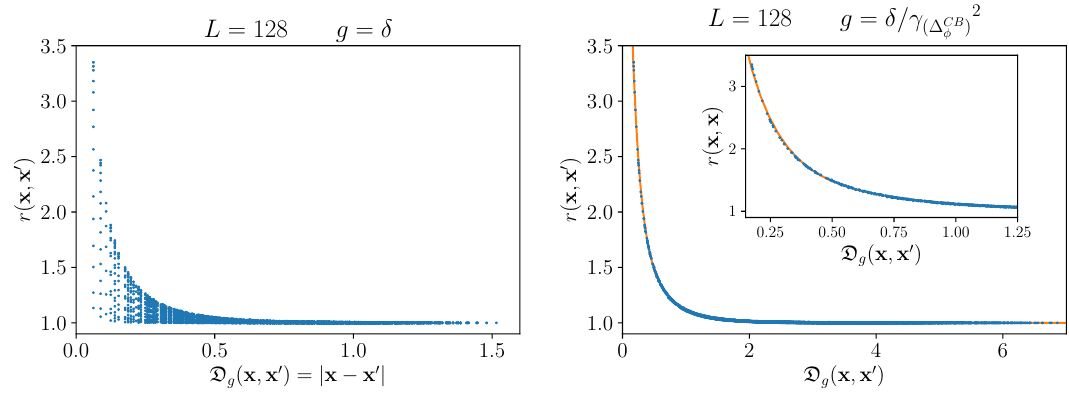
Figure 3 . Correlation ratio r ( x , x 0 ) = h φ ( x ) i − 1 h φ ( x 0 ) i − 1 h φ ( x ) φ ( x 0 ) i : on the right, plotted as a function of the euclidean distance: since that is not the “correct” metric, the points are scattered. On the right, the same points plotted as a function of the distance D metric which solves the fractional Yamabe equation for ∆ The points collapse onto one line. In the inset a zoom of the region where the ratio displays more pronounced variations is